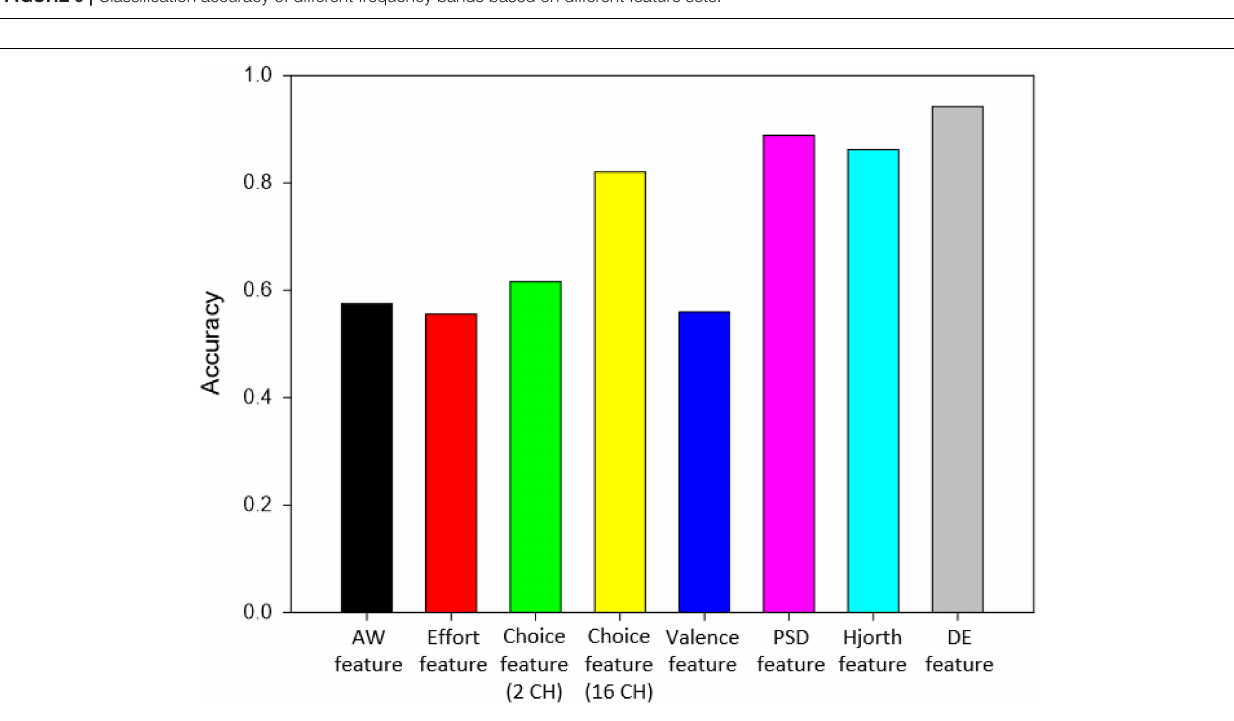
FIGURE 9 | Classification accuracy of different frequency bands based on different feature sets.